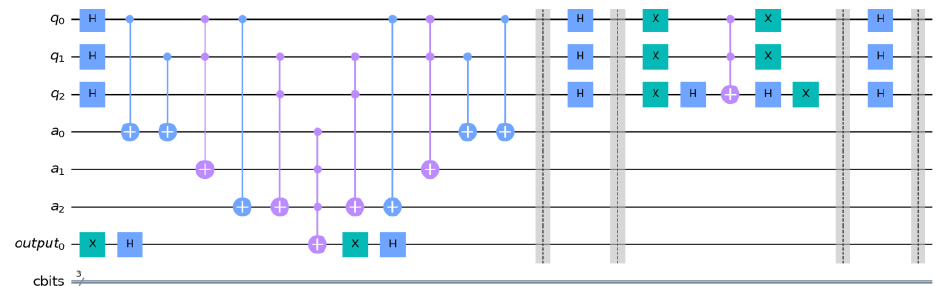
Figure 5. Quantum circuit diagram of three-variable Boolean equations.